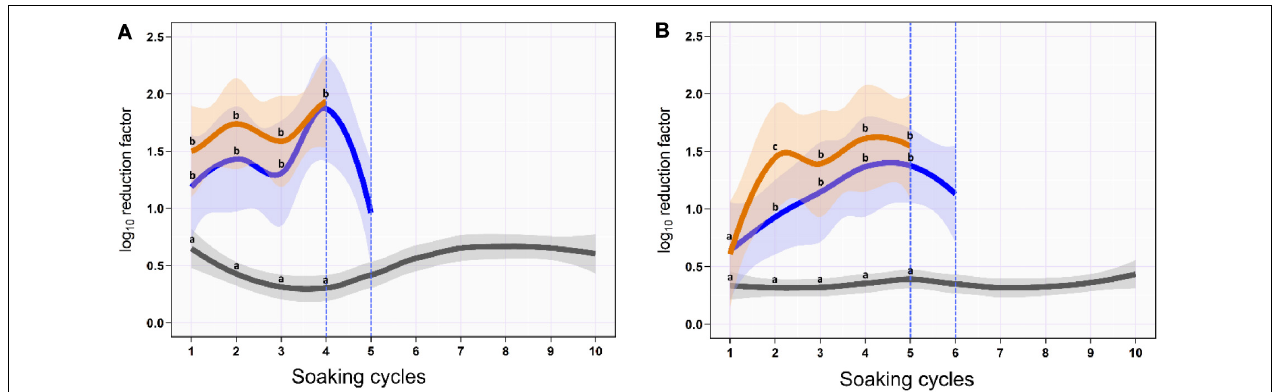
FIGURE 1 | Mean and 95% CI of the log 10 reduction in Salmonella typhimurium – choleraesuis (aSTC) cell count on the skin surface (A) and subcutaneous (B) of drumstick soaked with distilled water (gray), ozonated water of 8 ppm (blue), and ozone–lactic acid blend (orange) using multi-sequential soaking approach. The vertical dashed blue line indicates that no aSTC was